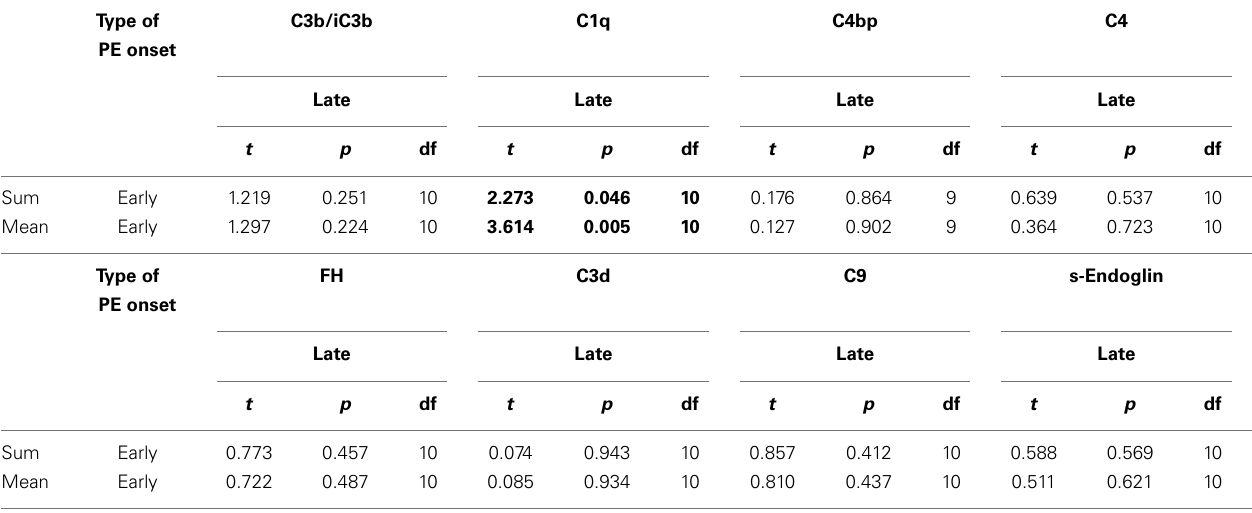
Table 5 | Complement and s-endoglin deposition in early- vs. late-onset preeclampsia (PE) .